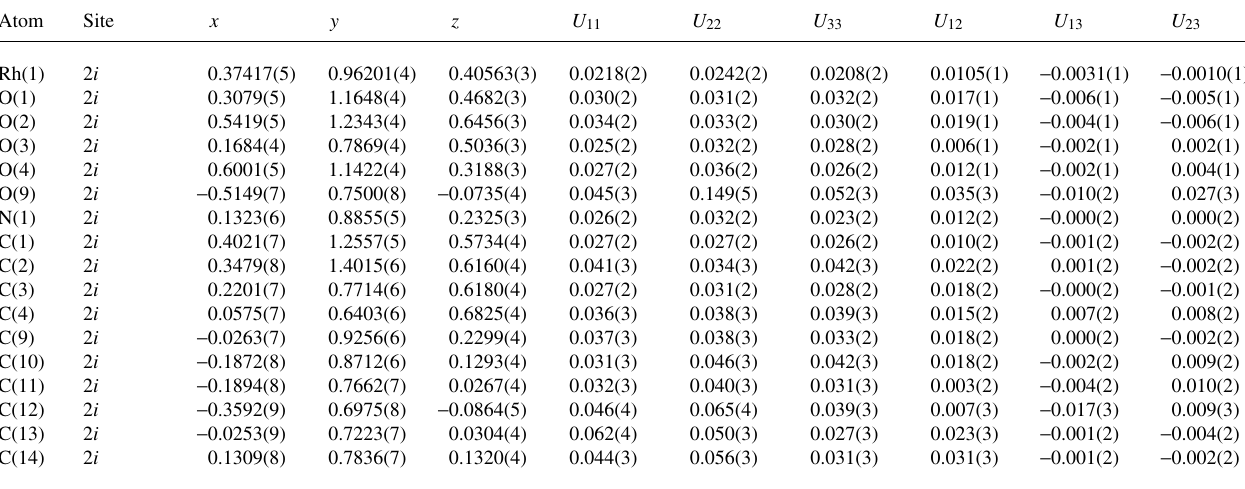
Table 3. Atomic coordinates and displacement parameters (in Å 2 )